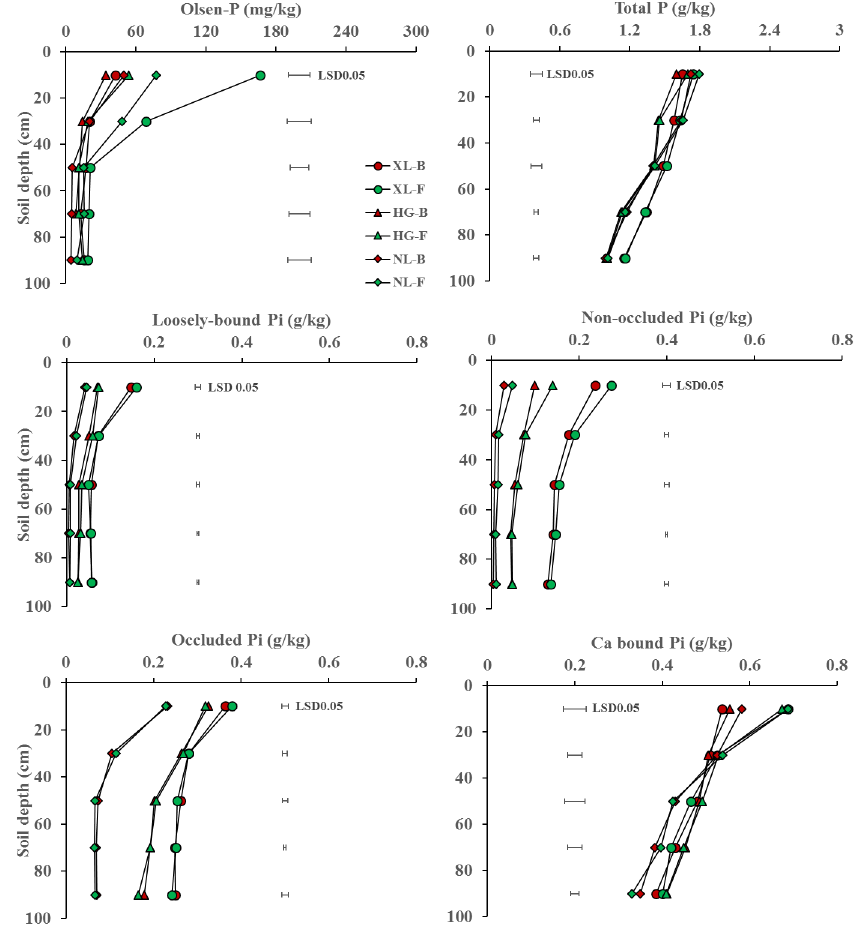
Figure 4. The concentrations of P forms in soil profiles at different land use sites. For abbreviations, see Fig.